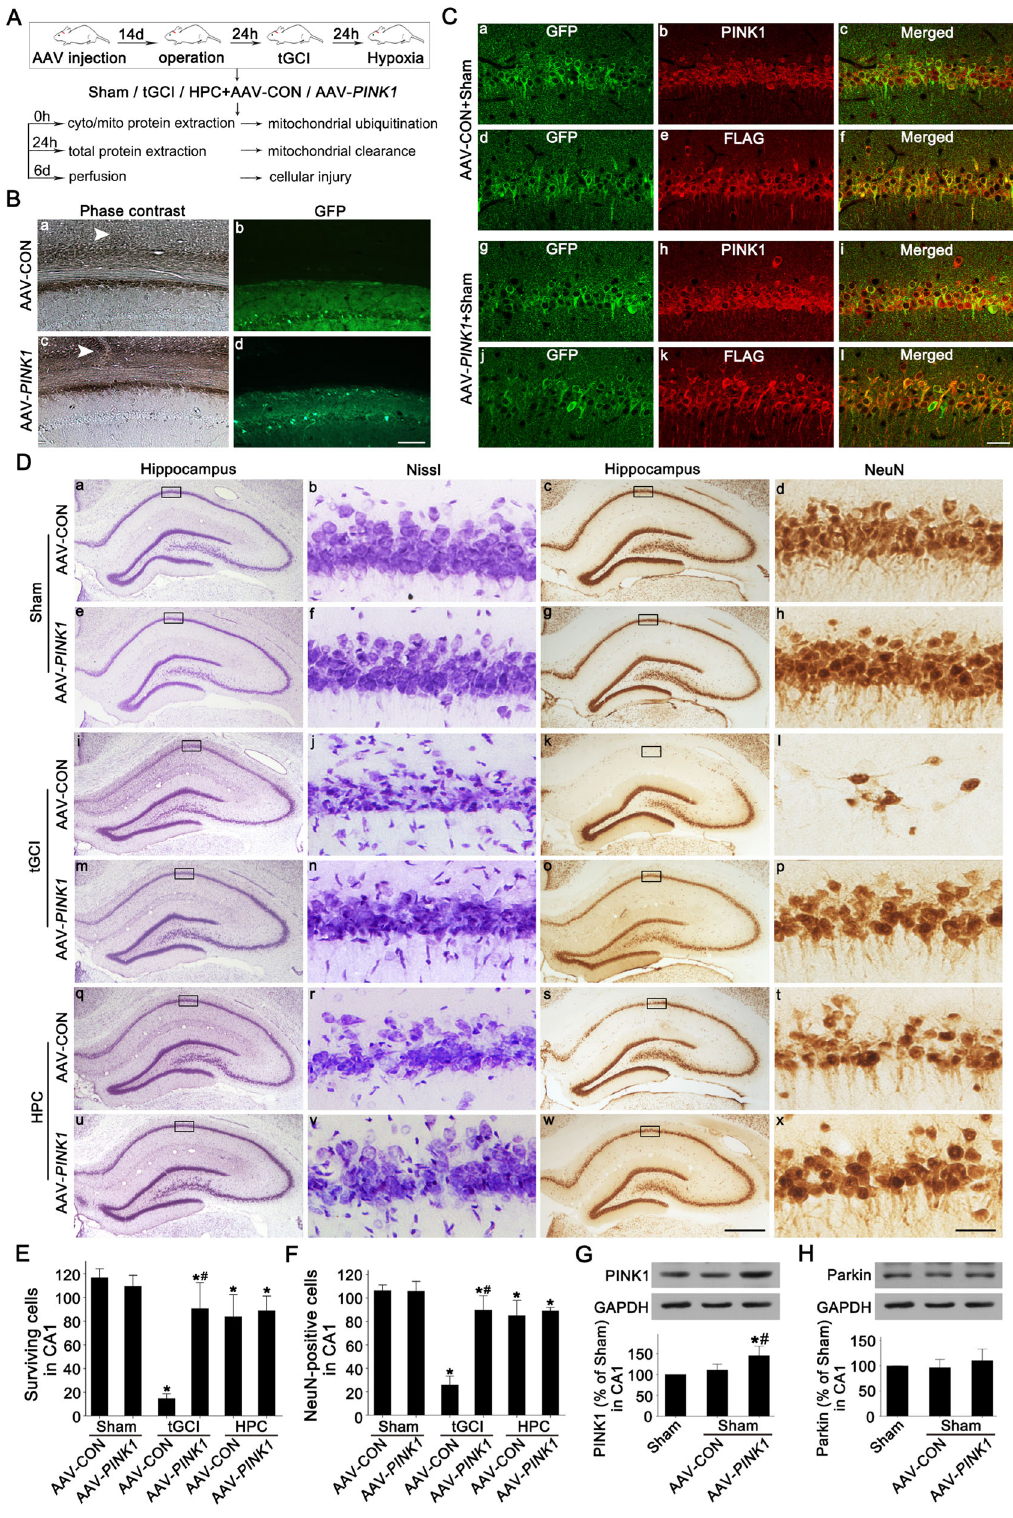
ubiquitin-proteasome system appears to be critical for mitophagy [28, 29]. Besides, Parkin-dependent poly-ubiquitination contri- butes to the recruitment of ubiquitin-binding autophagy receptor, such as p62/SQSTM1 which is known to connect the ubiquitin system and the autophagic machinery [51]. These